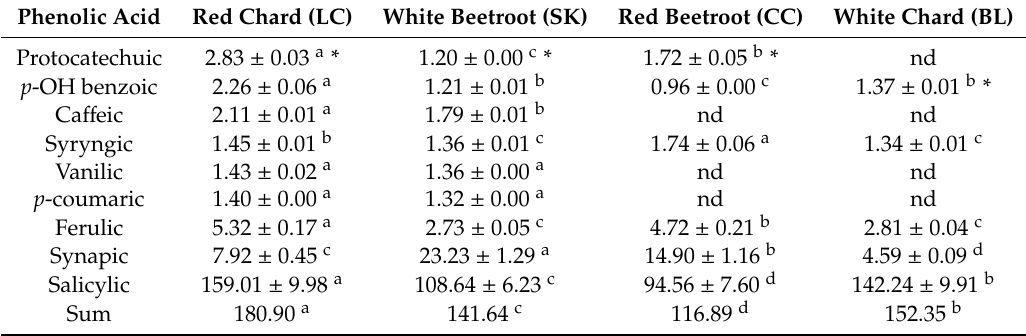
Table 1. Phenolic acids content in leaves of white beetroot (SK), beetroot (CC), white chard (BL), and red chard (LC) [mg / 100 g